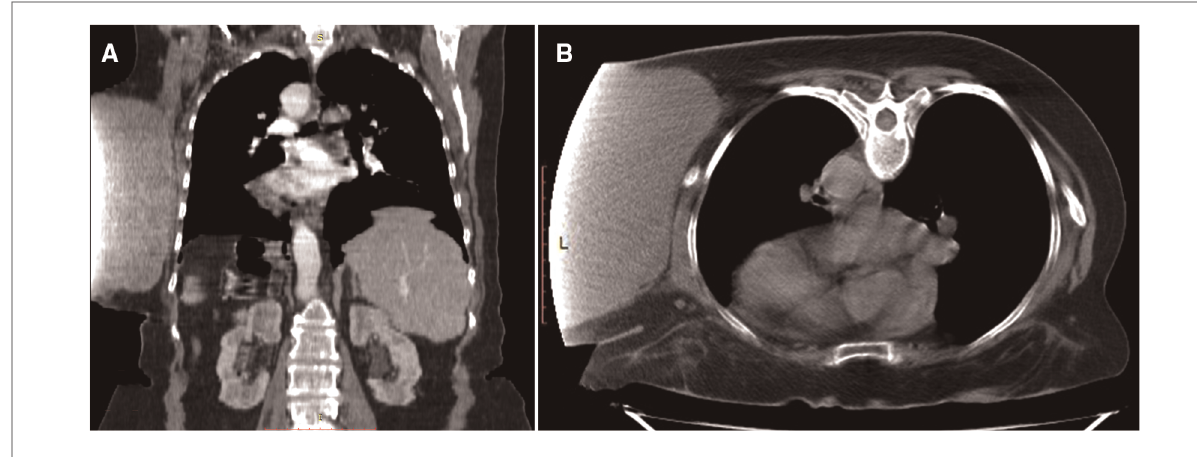
Surgery is an essential part of the multimodal treatment scheme for thoracic sarcomas. However, the evidence of postoperative recurrence can be found in 23% of patients.